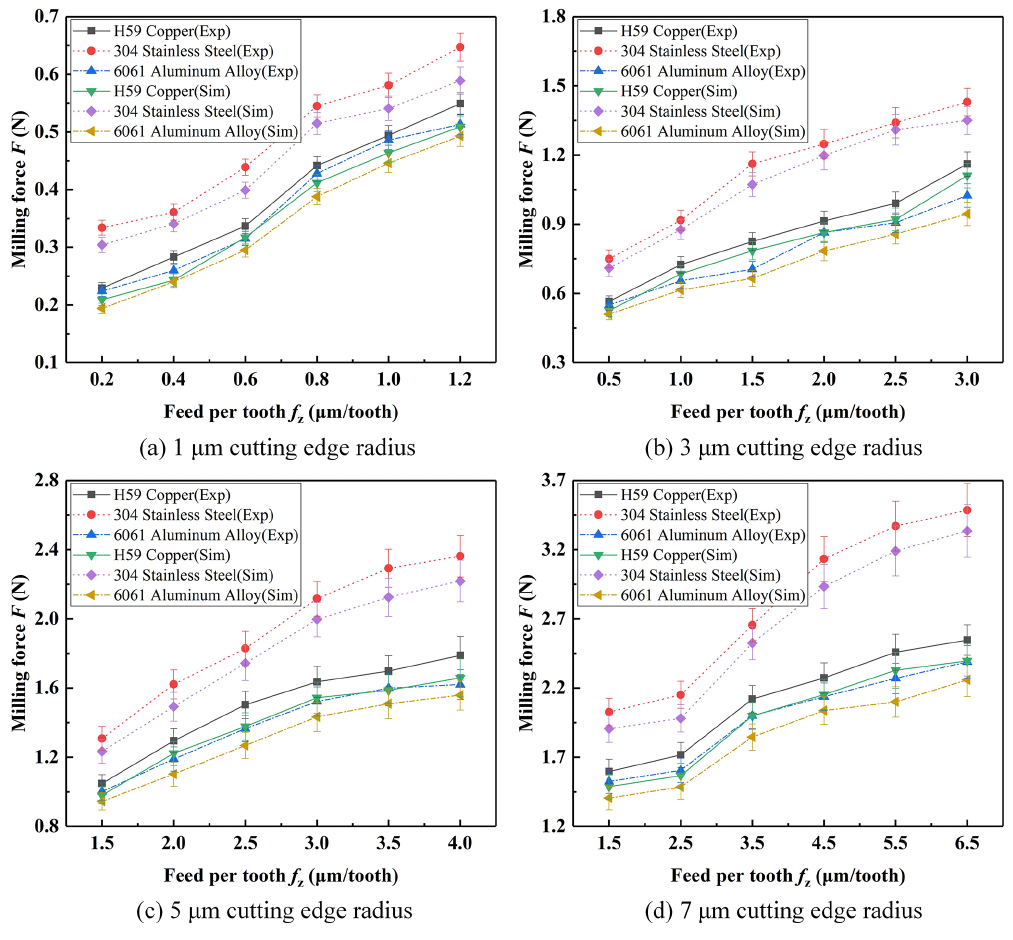
Figure 6. Milling force results of end cutting edge.